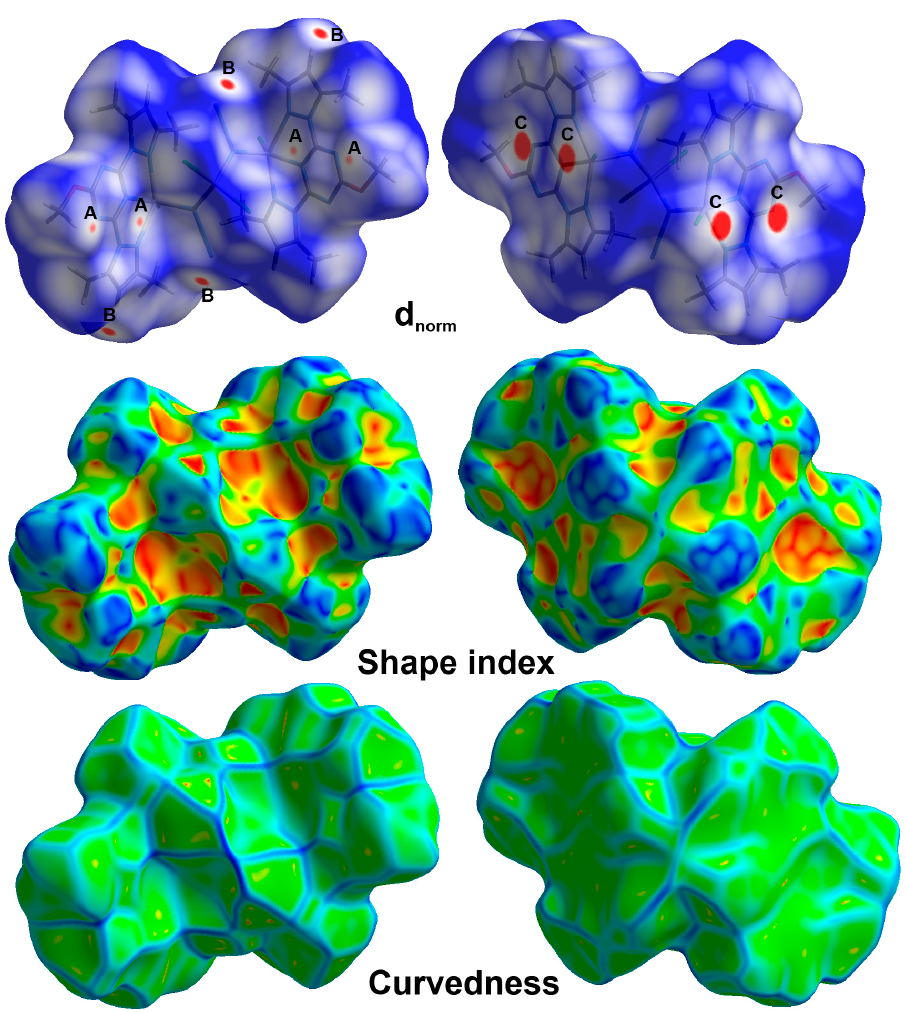
Figure 5. Hirshfeld surfaces for the trinuclear Zn(II) complex. The letters A, B, and C in the d norm map refer to the H…C, N…H, and Cl…C contacts, respectively.